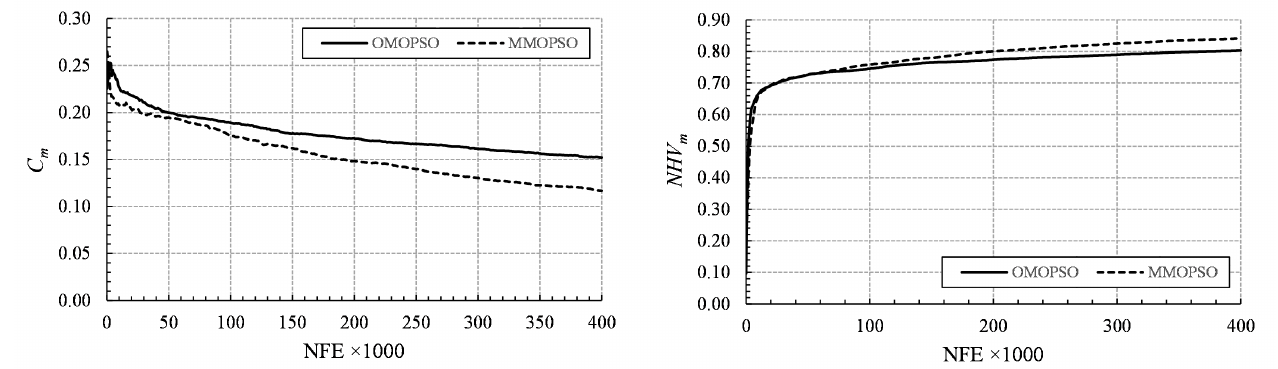
Figure 4. Average curves of runtime C m and NHV m for 15 runs using the OMOPSO and MMOPSO algorithms in BIN network.